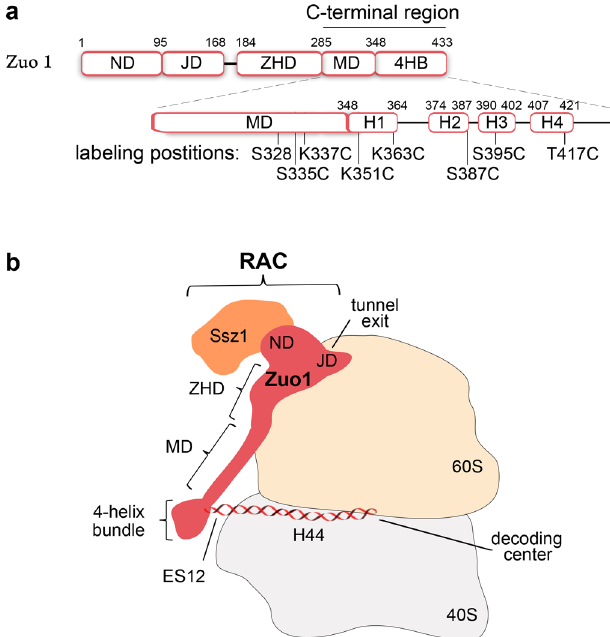
Figure 1. Domain organization of Zuo1 and its interaction with the ribosome. ( a ) Domains: N-terminal domain (ND), J-domain (JD), Zuo1 Homology Domain (ZHD), middle domain (MD), four-helix bundle (4HB). The labeling positions for EPR spectroscopy (cysteine substitutions) are marked. ( b ) Model of the RAC– ribosome